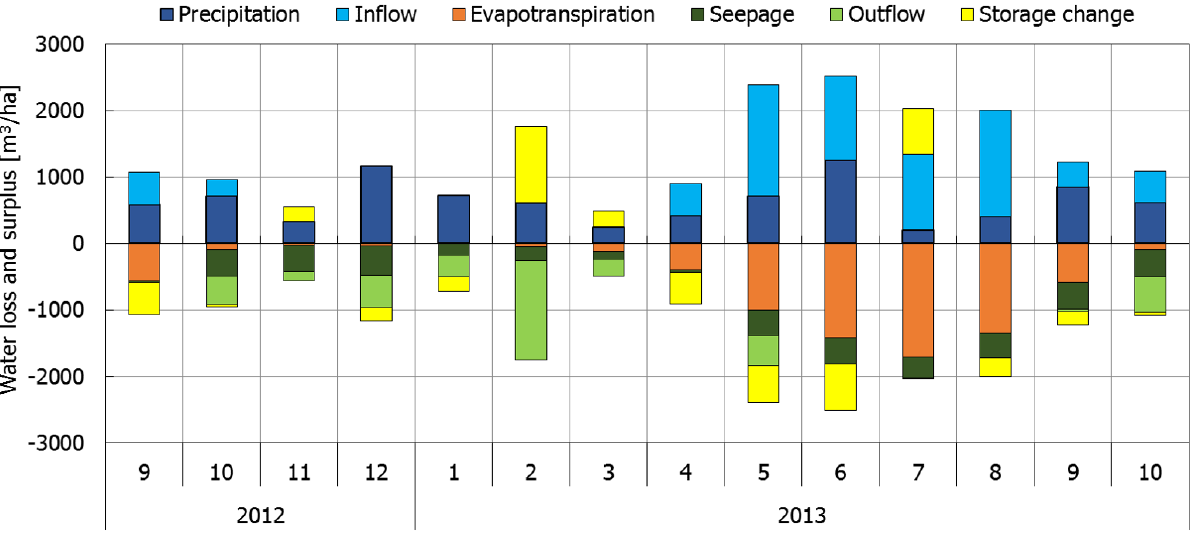
Figure 6. Monthly fluxes for different water balance components (m³ ha -1 ) and storage change for the period September 2012 to October 2013.